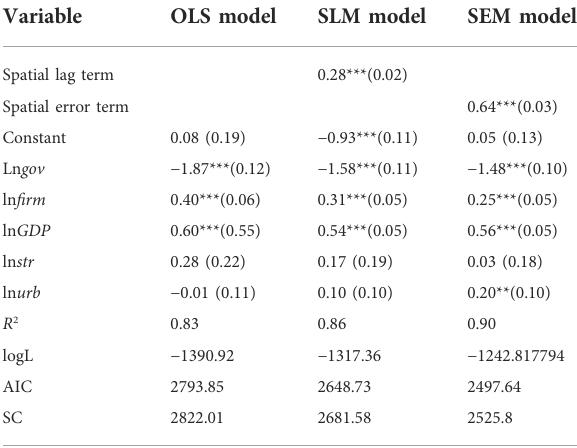
TABLE 3 OLS and spatial econometric model estimation